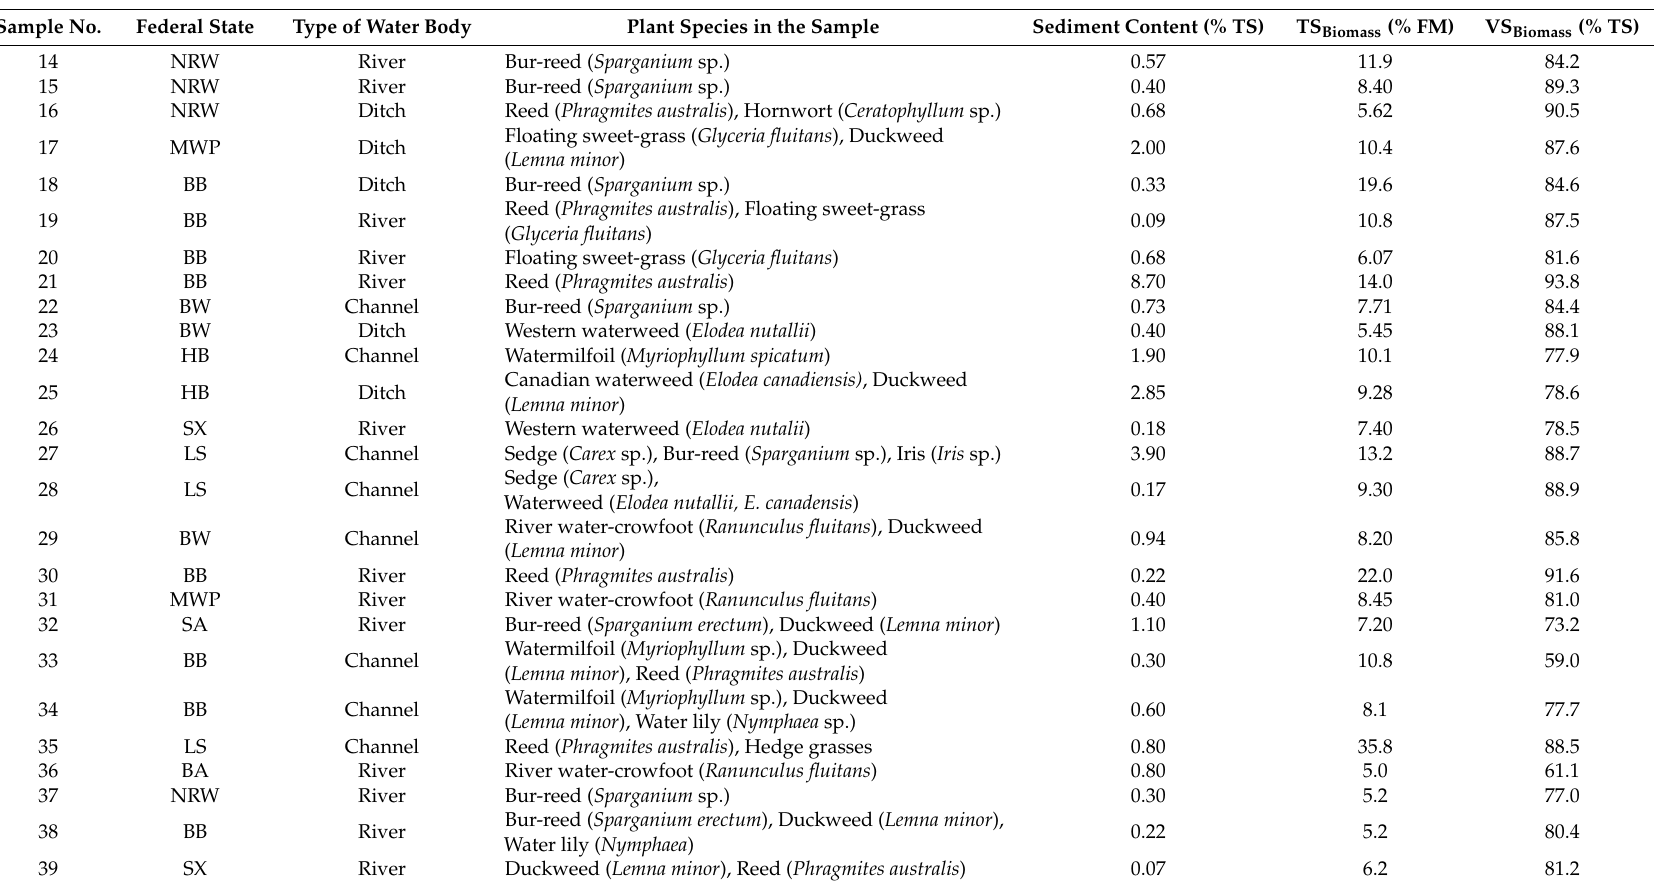
Table 2. Properties of plant material in samples from flowing bodies of water (samples 33–39 are from summer harvesting). Sample